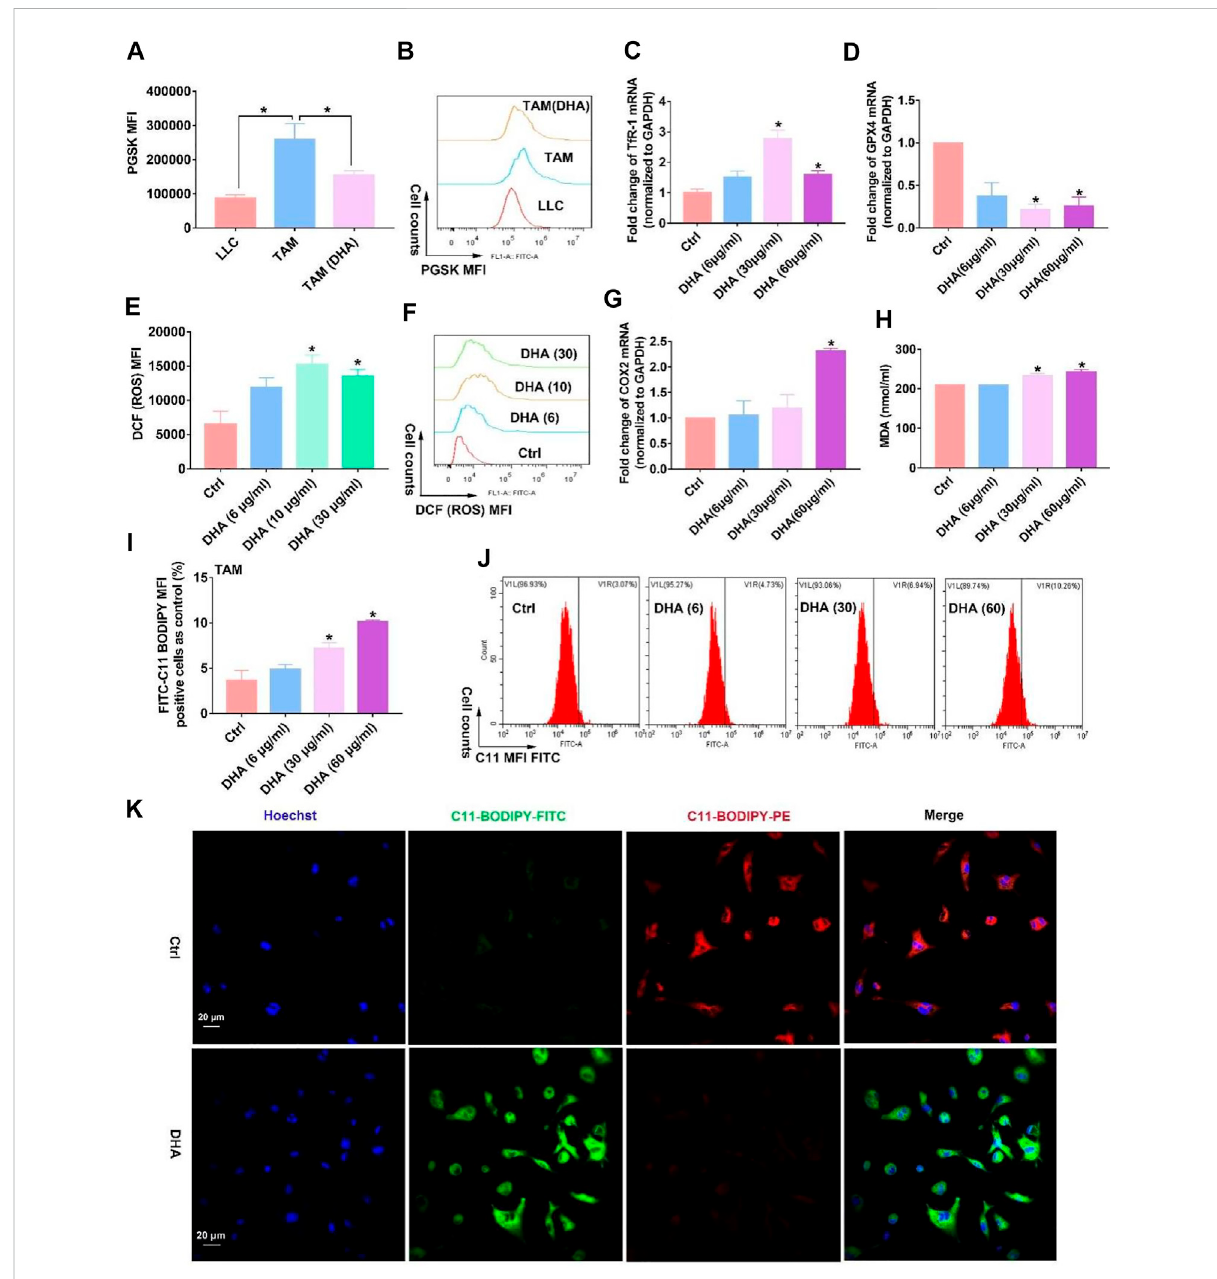
FIGURE 3 DHAtreatmentofTAMresulted intheaccumulationofironionsandinhibitionofGPX4l,thusgenerating ROSandLPOandinducing ferroptosis invitro . (A,B) IntracellularironionswereassayedusingthePGSKprobeand fl owcytometry. (C,D) TfR-1andGPX4mRNAexpressionwasanalyzedby the RT-PCR. (E,F) ROS generation in TAM was detected by the DCFH-DA probe. (G) COX-2 mRNA expression was analyzed by RT-PCR. (H) MDA concentration in TAM was measured using an MDA Assay Kit. (I,J) C11-BODIPY fl uorescent dye was applied to detect LPO production wherein FITC fl uorescence-positive cells represented accumulated LPO. (K) Cellular LPO generation was observed by confocal microscopy. Geometric means were applied to quantify the MFI. Values were means ± SD ( n = 3, * p < 0.05 when compared with the control